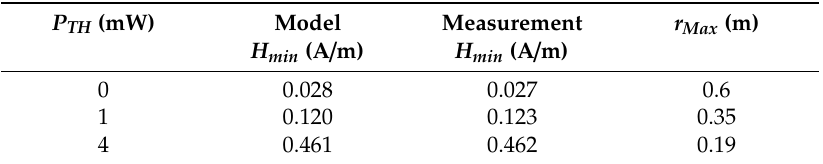
Table 7. Comparison of measurement and calculation results of r Max for a RFID sensor for di ff erent loads P TH of internal energy